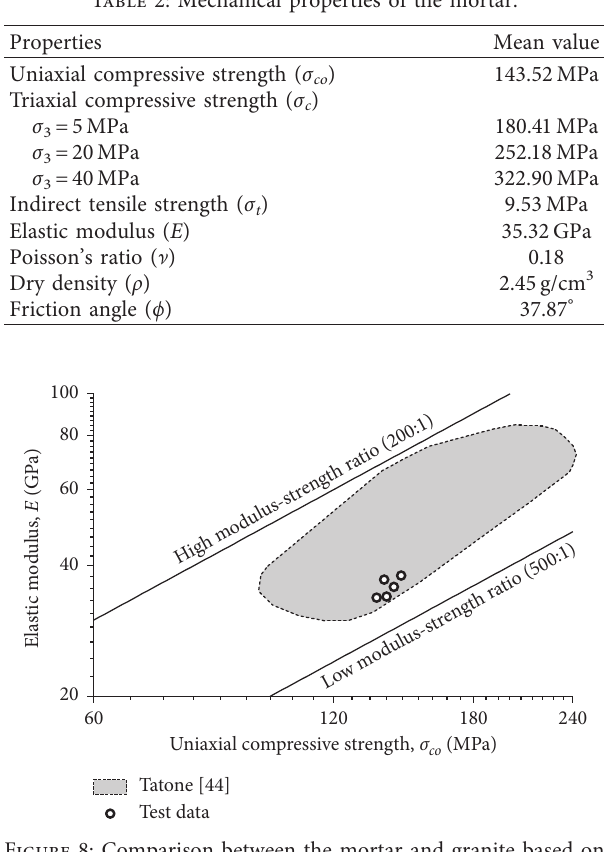
Figure 8: Comparison between the mortar and granite based on deformation index E / σ co